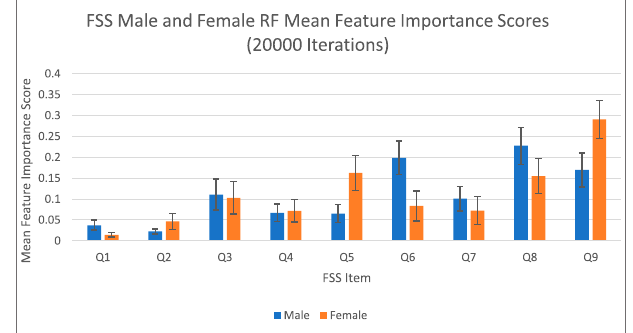
FIGURE 2 | FSS male and female random forest mean feature importance scores and standard deviations for 20,000 iterations. Error bars represent 1